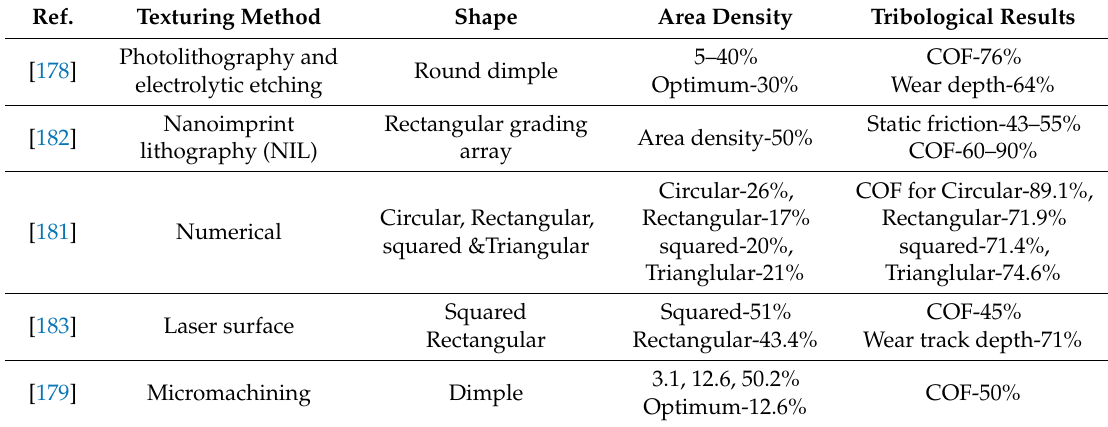
Table 5. Effect of texturing on tribological performance.